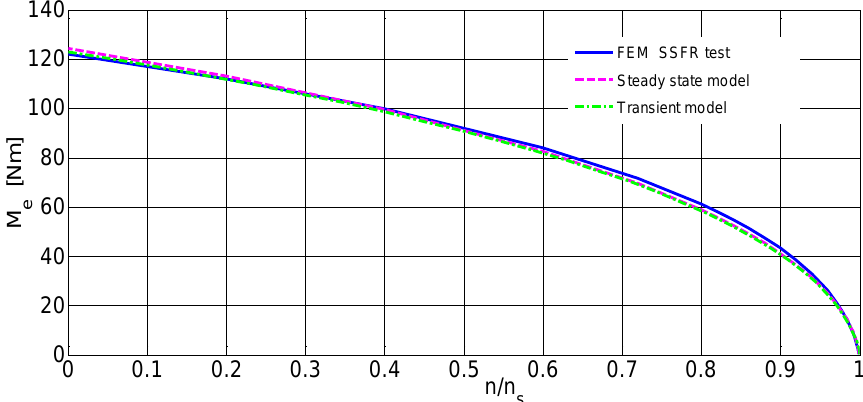
Figure 16. Dependence of the electromagnetic torque on the rotational speed.